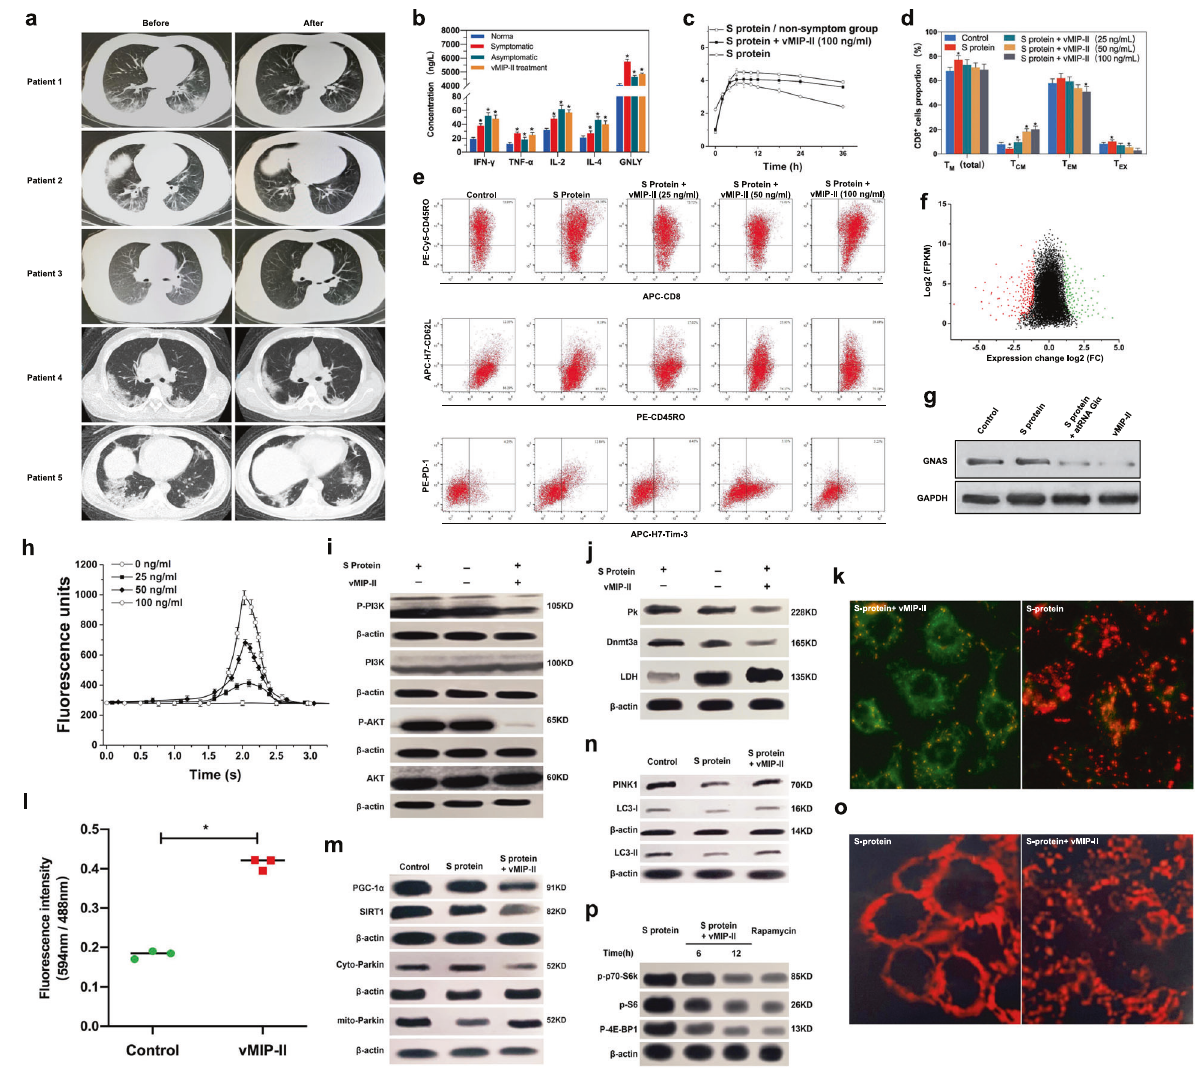
Fig. 1 Chemokine receptor inhibitor vMIP-II promotes the conversion of effector CD8 + T into T CM cells in the reconstitution of cellular immunity in patients with COVID-19. a Reduction of lesions of lung CT treated by vMIP-II. Five common patients with SARS-CoV-2 virus were scanned by lung CT before and 1 week after vMIP-II treatment. The ground glass lesions and white areas of the lungs were signi fi cantly alleviated after 1-week treatment. b Cytokine level of different groups of PBMCs stimulated by S protein in convalescent patients after 1 week of being negative. Different groups of separated PBMCs were added with S protein (100 ng/mL S1 + S2, w/w = 2:1) and detected by cytokine kits, * p value < 0.05. c Proliferation of PMBCs stimulated by S protein in convalescent groups after 1 week of being negative. Compared with the common symptomatic group, vMIP-II group and non-symptomatic group, * p -value < 0.05 ( n = 5). d Flow cytometry detection of memory CD8 + T cells. Different subgroups of memory CD8 + T cells were distinguished by CD45RA and CD62L. The third line was the detection of inhibitory molecules on the surface of CD8 + T cells. The depleted CD8 + T cells (T EX ) were distinguished by the highly expressed inhibitory molecules PD-1 and Tim-3. e Proportion and distribution of CD8 + T-cell subgroups in different vMIP-II to S protein. Compared with